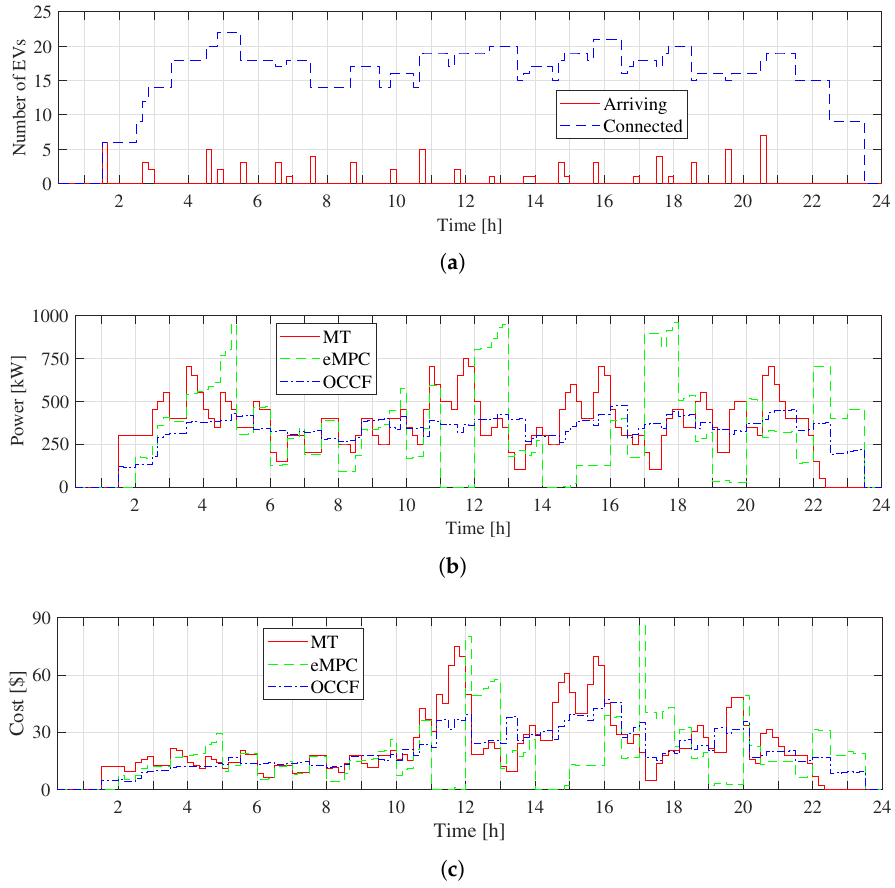
Figure 8. The behaviour of the three charging strategies in the EVCS. ( a ) EV arrival and EVs connected in the operational time. ( b ) Power delivered. ( c ) EVCS